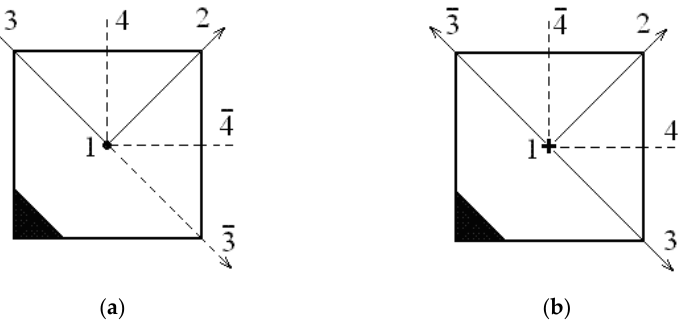
Figure 3. The schemes of the choice of coordinate system on the sample of Х /45 ° -cut: the system in figure ( b ) is obtained from the one in figure ( а ) by its rotation at the angle of 180 ° around axis 2. If the uniaxial pressure was applied along the direction 1 ( m = 1), we chose the di- rection of light polarization in the same direction ( і = 1) and the direction of light propa-